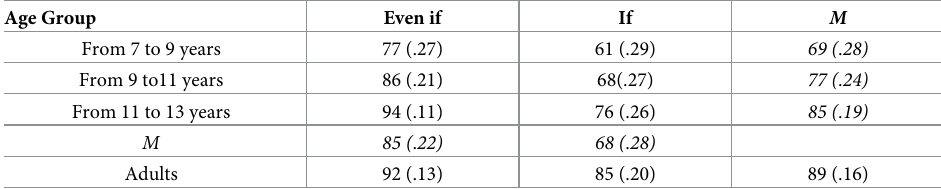
Table 2. Percentage of correct responses in inferential response in Studies 1 with adults and 2 with